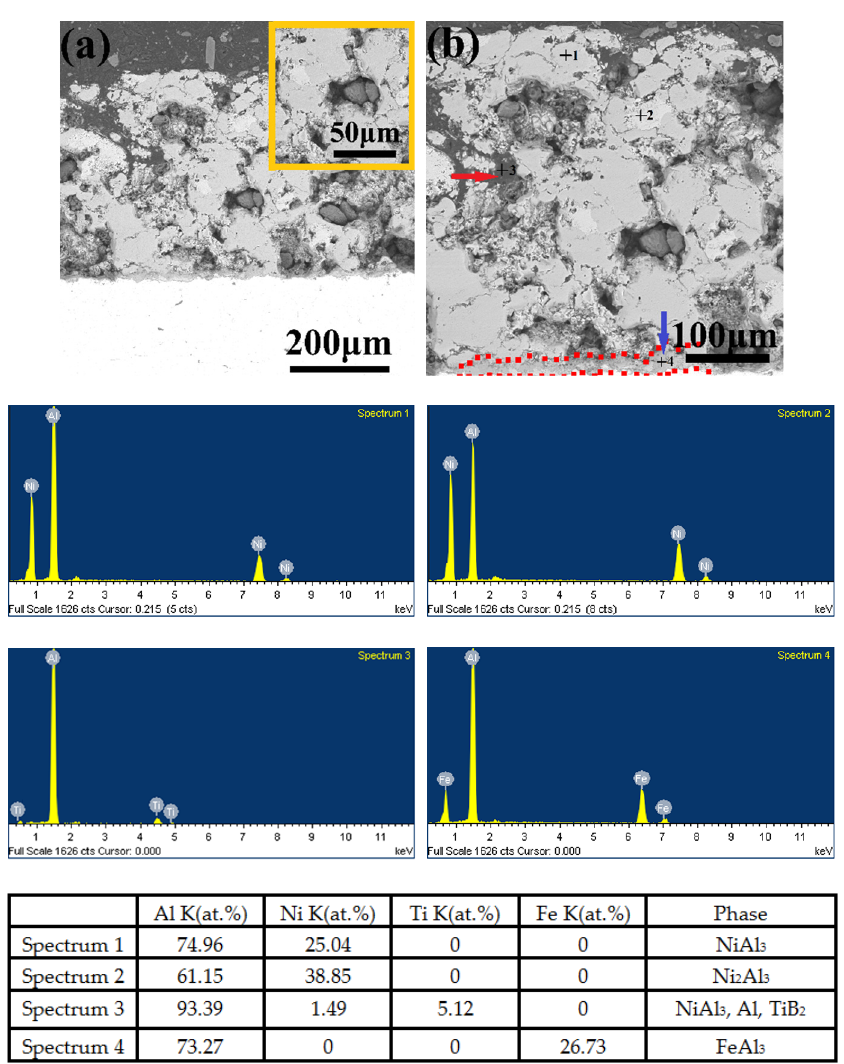
Figure 12. Cross-sectional morphologies and compositions of Ni/Al-TiB 2 coatings as-sprayed at 250 °C and after annealing at 650 °C for 20 h: ( a ) 200×, and ( b ) 500×.